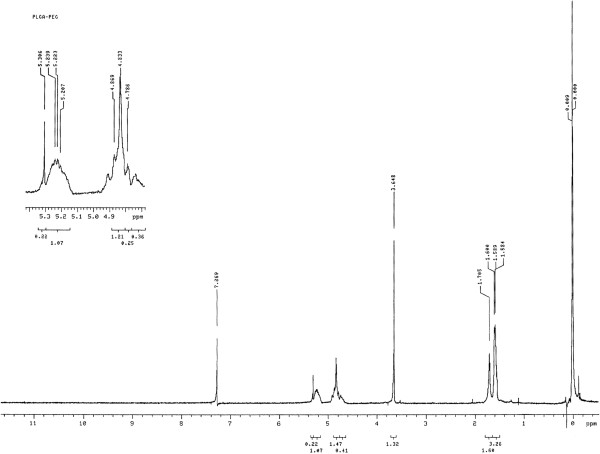
1H NMR spectrum of PEG–PLGA copolymer.